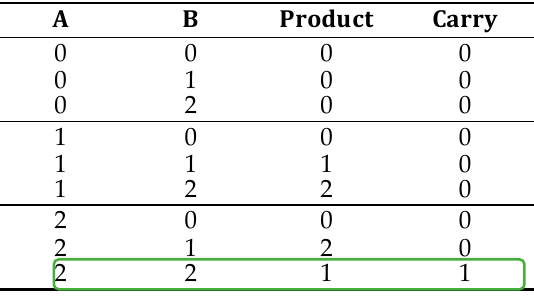
Table 1. Truth Table of One-Trit Ternary Multiplier.